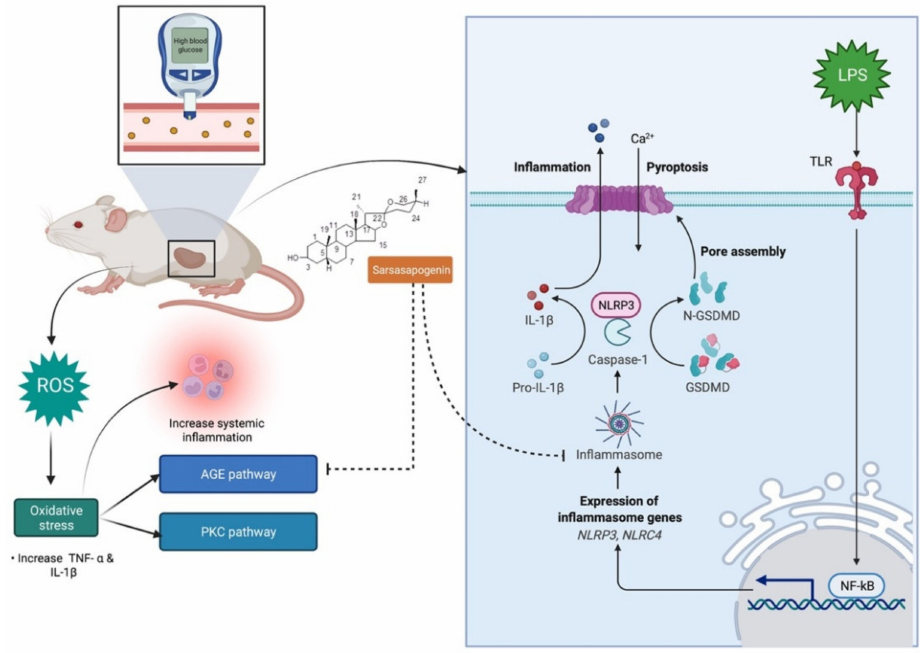
Figure 6. Sarsasapogenin mechanism of action in inflammasome activation and AGE. NLRP3 is triggered by a wide variety of stimuli, including LPS via Toll-like receptors (TLR), which results in the manufacture of the cytokine precursor via NF-kB and other inflammasome constituents, including NLRP3. Sarsasapogenin inhibits the activation of the NLRP3 inflammasome and the AGE pathway, vastly improving diabetic nephropathy in rats. Abbreviations: N-GSDMD, N-terminal Gasdermin-D; GSDMD, Gasdermin-D; NLRP3, NLR family pyrin domain containing 3; NLRC4, NLR Family CARD Domain Containing 4; AGE, Advanced glycation end products; PKC, Protein kinase